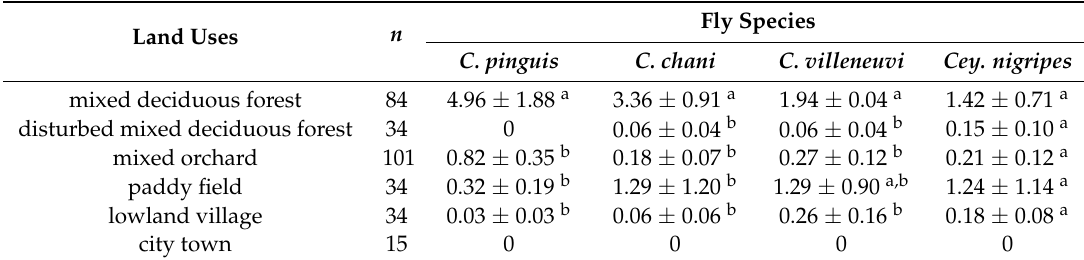
Table 2. Mean number of Chrysomyinae flies collected based on land use types in Chiang Mai province, May 2009–May 2010. Land Uses